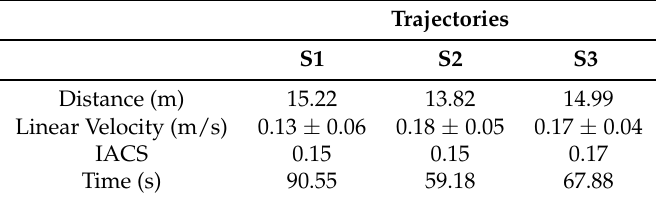
Table 1. Results obtained from the simulation. Integral of absolute control signals (IACS).